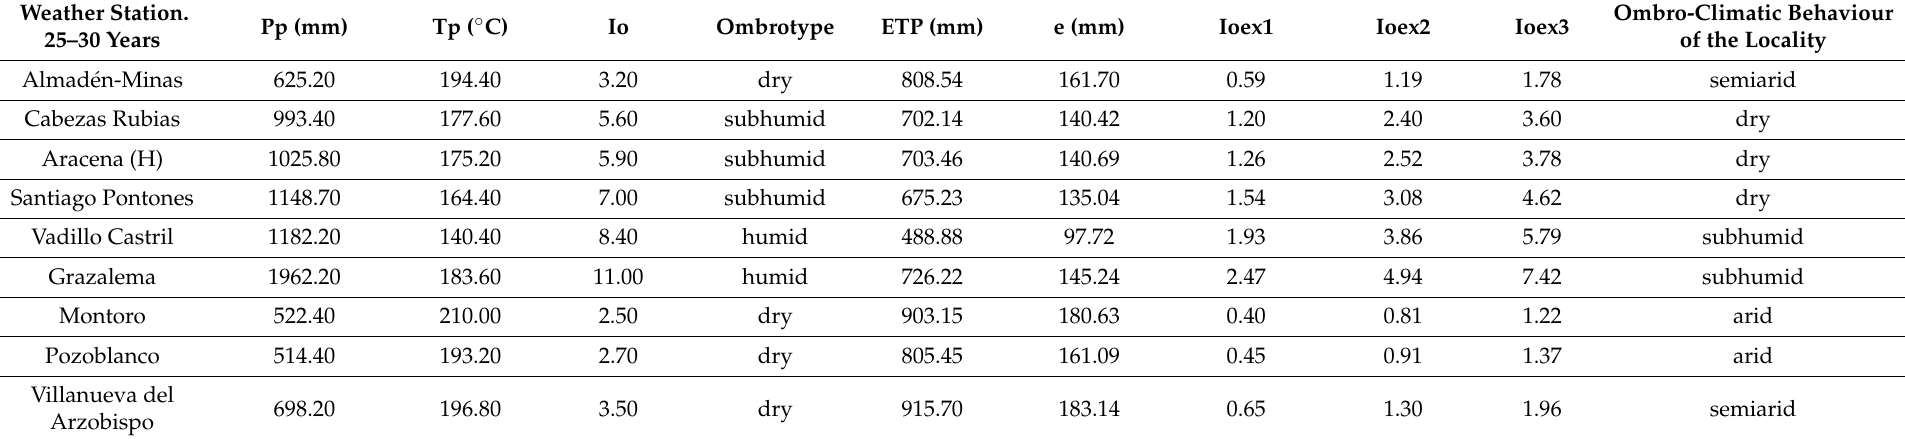
Table 1. Comparative value of Io and I oex indices in some localities in the southern Iberian Peninsula. Pp = Positive precipitation (mm), Tp = Positive temperature ( ◦ C), Io = Ombro-climatic index, ETP = Potential evapotranspiration (mm), e = residual evapotranspiration, Ioex1, Ioex2 and Ioex3 = Summer ombro-climatic indices (CR = 0.25, 0.5 and 0.75, respectively). Ombro-climatic behavior of the locality is synonymous with ombrotype applied to a specific locality. Weather